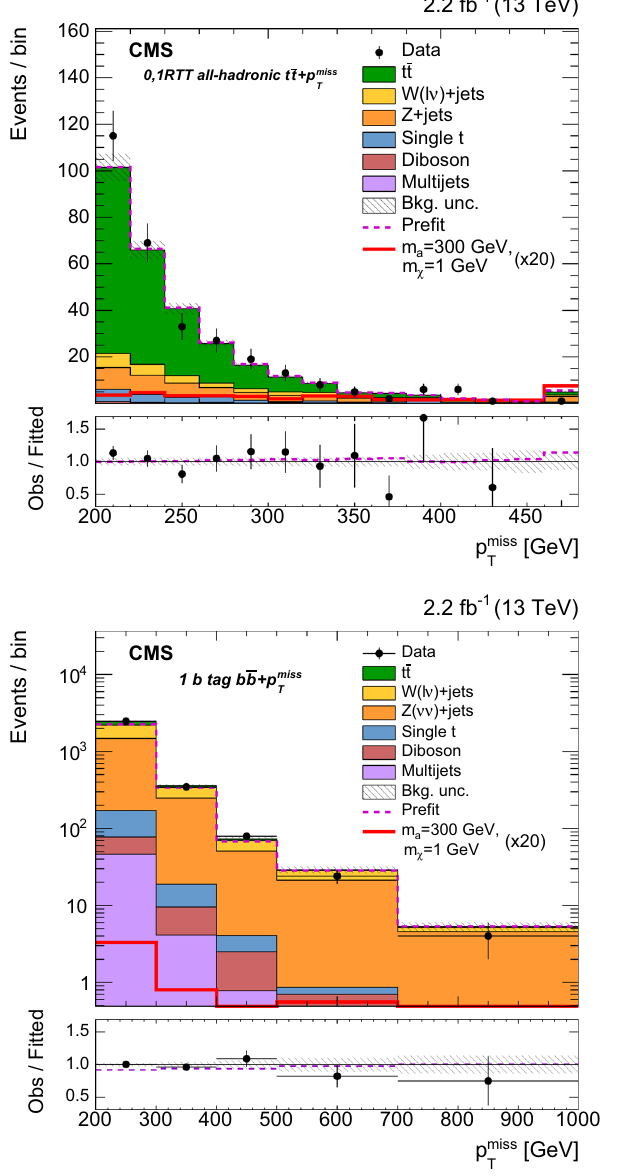
trigger Uncertainties of 0.3–2% (depending on the – p miss T SR) are associated with the efficiency scale factors of the p miss trigger. The efficiency of this trigger is measured T using data collected with the single-lepton triggers. For > 200 GeV, these data primarily consist values of p miss T of W + jets events.